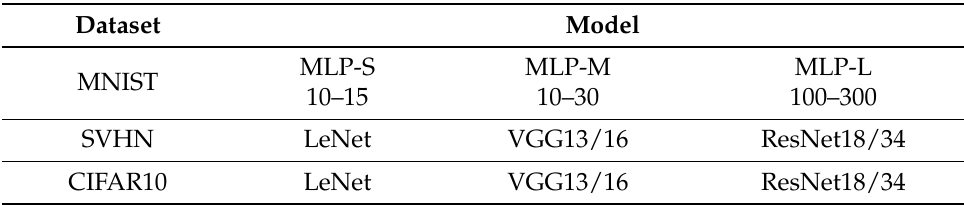
Table 1. Dataset and